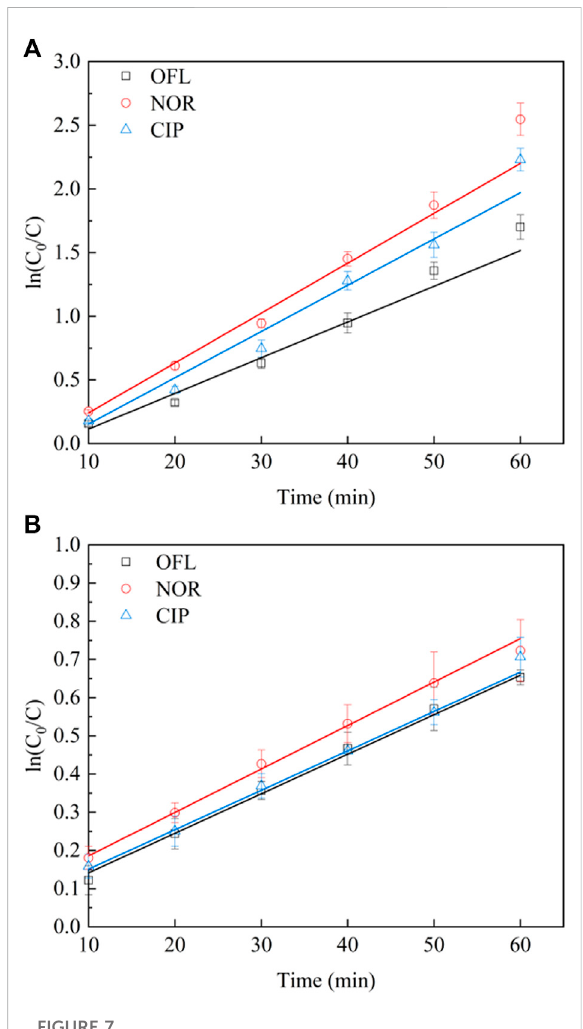
FIGURE 7 The removal ef fi ciency of (A) antibiotic and (B) DOC on 10%